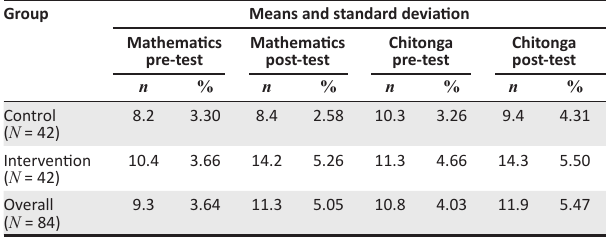
TABLE 1: Raw scores for Mathematics and Chitonga at the control and intervention schools. Group